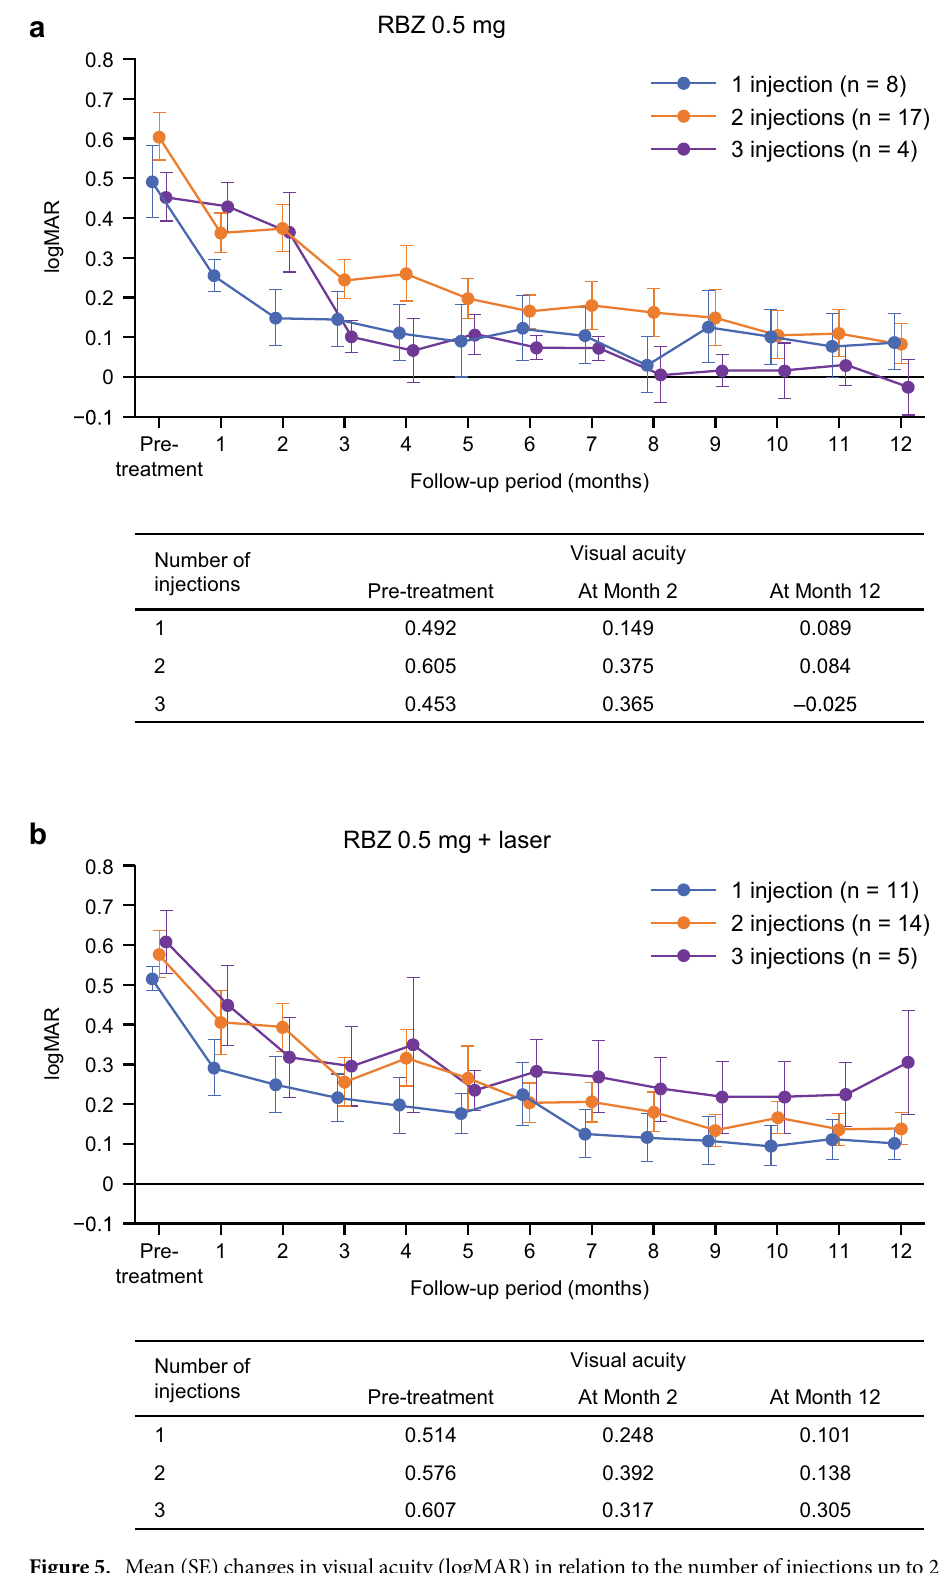
Figure 5. Mean (SE) changes in visual acuity (logMAR) in relation to the number of injections up to 2 months after the start of treatment. ( a ) Ranibizumab 0.5 mg monotherapy. ( b ) Ranibizumab 0.5 mg plus laser. ( c ) All patients. logMAR logarithm of the minimum angle of resolution, RBZ ranibizumab, SE standard